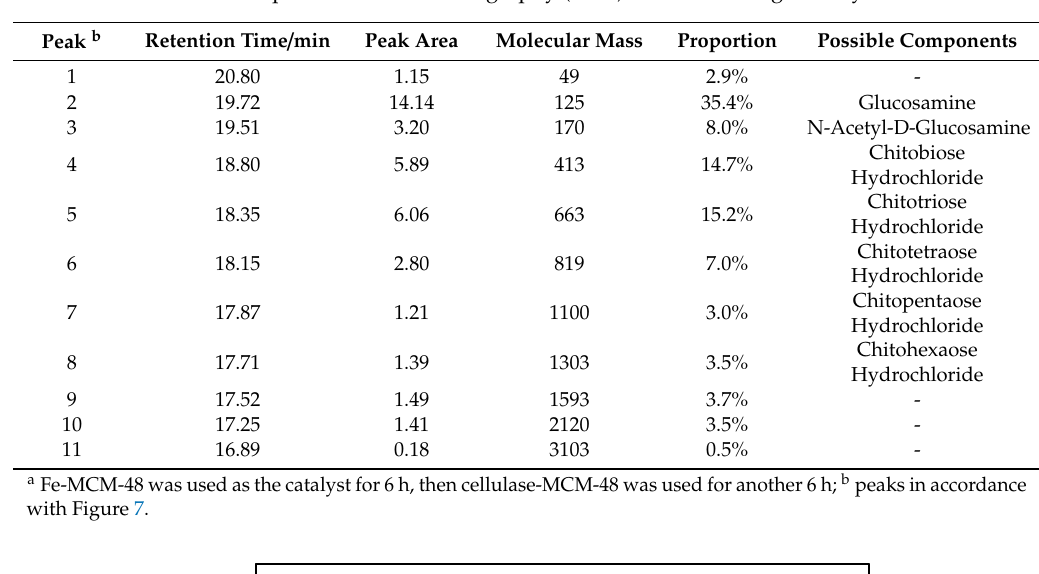
Table 4. Gas permeation chromatography (GPC) molecular weight analysis a .